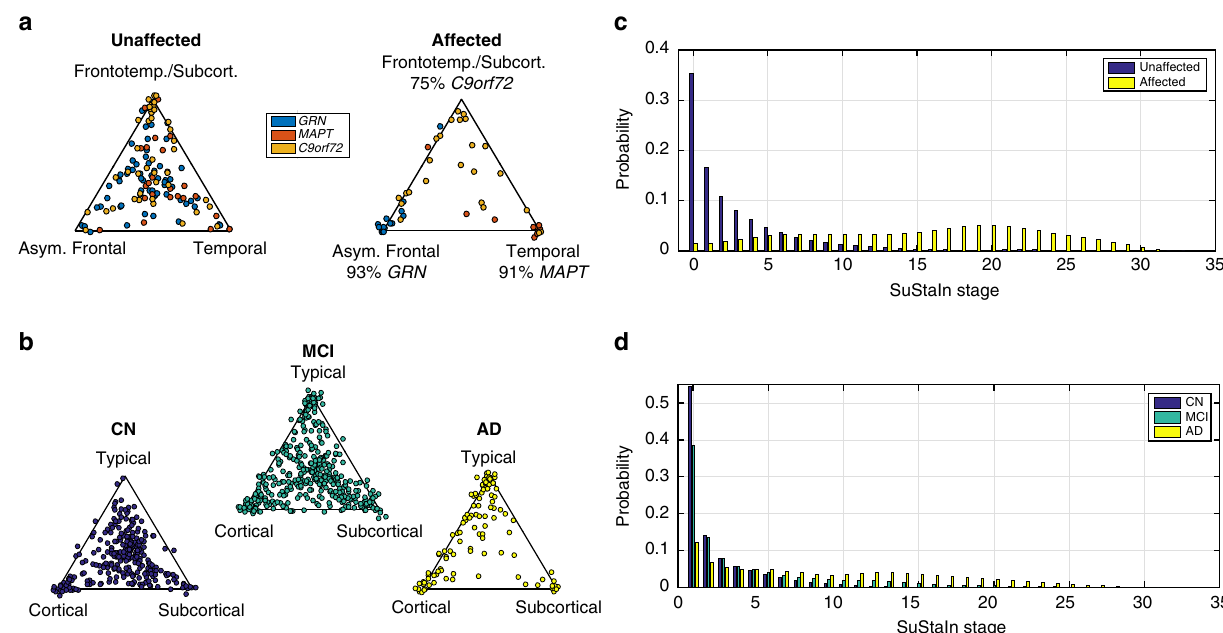
Fig. 5 SuStaIn subtyping and staging of genetic frontotemporal dementia and Alzheimer ’ s disease. a , b The assignability of the disease subtypes estimated by SuStaIn for genetic frontotemporal dementia, and Alzheimer ’ s disease. Each scatter plot visualises the probability that each individual belongs to each of the SuStaIn subtypes estimated for a genetic frontotemporal dementia (as shown in Fig. 2a), and b . Alzheimer ’ s disease (as shown in Fig. 3). In the triangle scatter plots, each of the corners corresponds to a probability of 1 of belonging to that subtype, and 0 for the other subtypes; the centre point of the triangle corresponds to a probability of 1/3 of belonging to each subtype. c , d The probability subjects from each of the diagnostic groups belong to each of the SuStaIn stages for c genetic frontotemporal dementia and d Alzheimer ’ s disease. CN = cognitively normal; MCI = mild cognitive impairment;